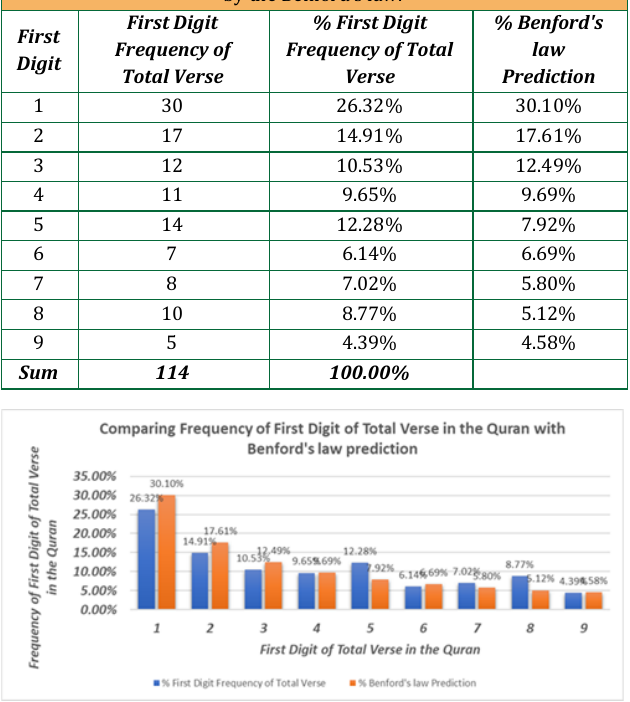
Figure 1: This chart shows frequency percentage of first digit of total verse in the Quran and frequency percentage of first digit predicted by the Benford’s law.